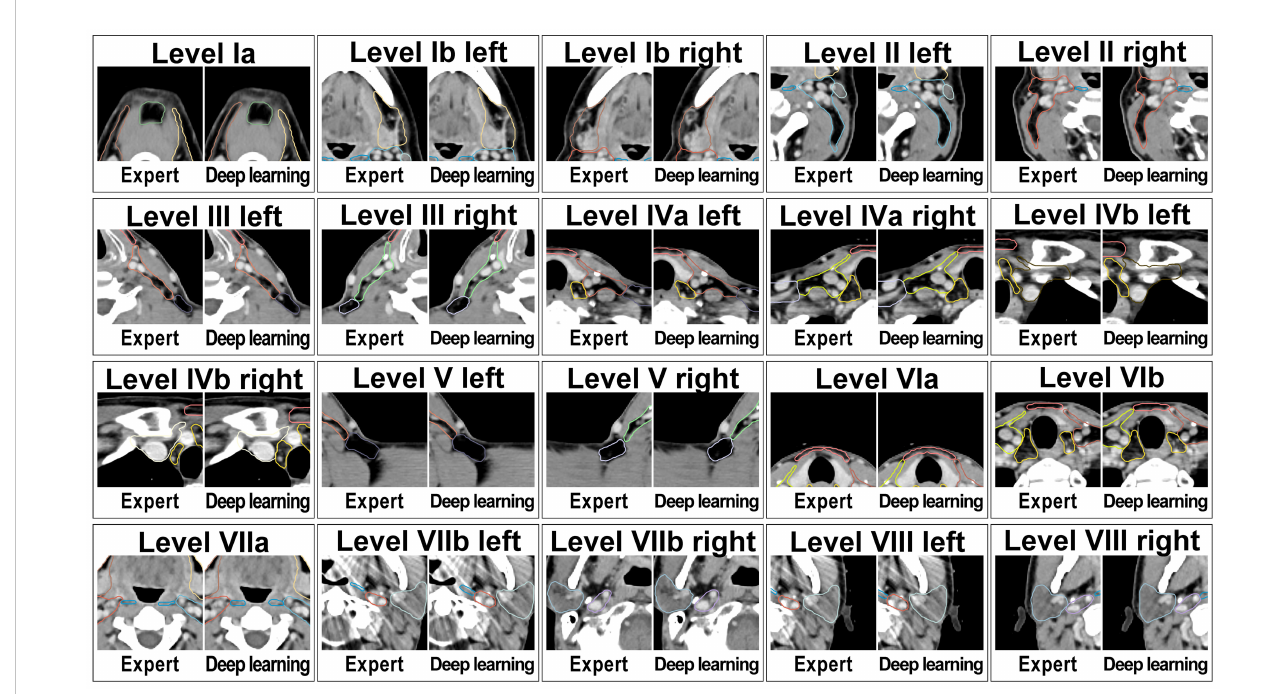
FIGURE 2 Expert-created lymph node level contours and deep learning autocontours side-by-side for each of the 20 evaluated head and neck nodal levels in an exemplary test set patient